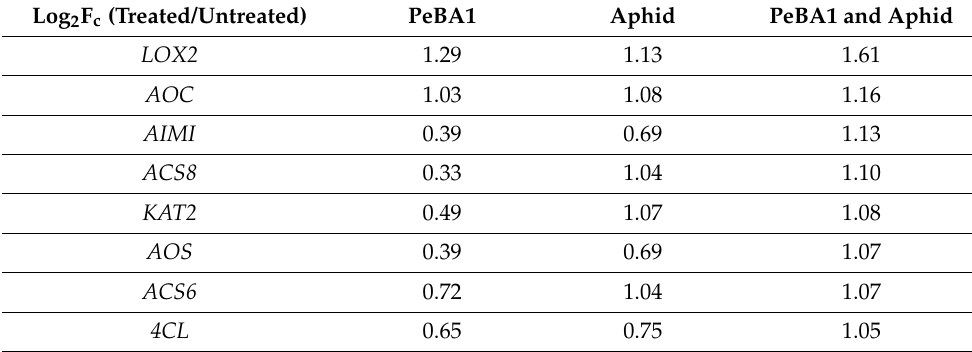
Table 3. Log2 of fold change expressions all test genes involved in the JA, SA, and ET pathways after PeBA1 elicitor application, PeBA1 and aphid, and aphid infestation alone. Log 2 F c (Treated/Untreated)